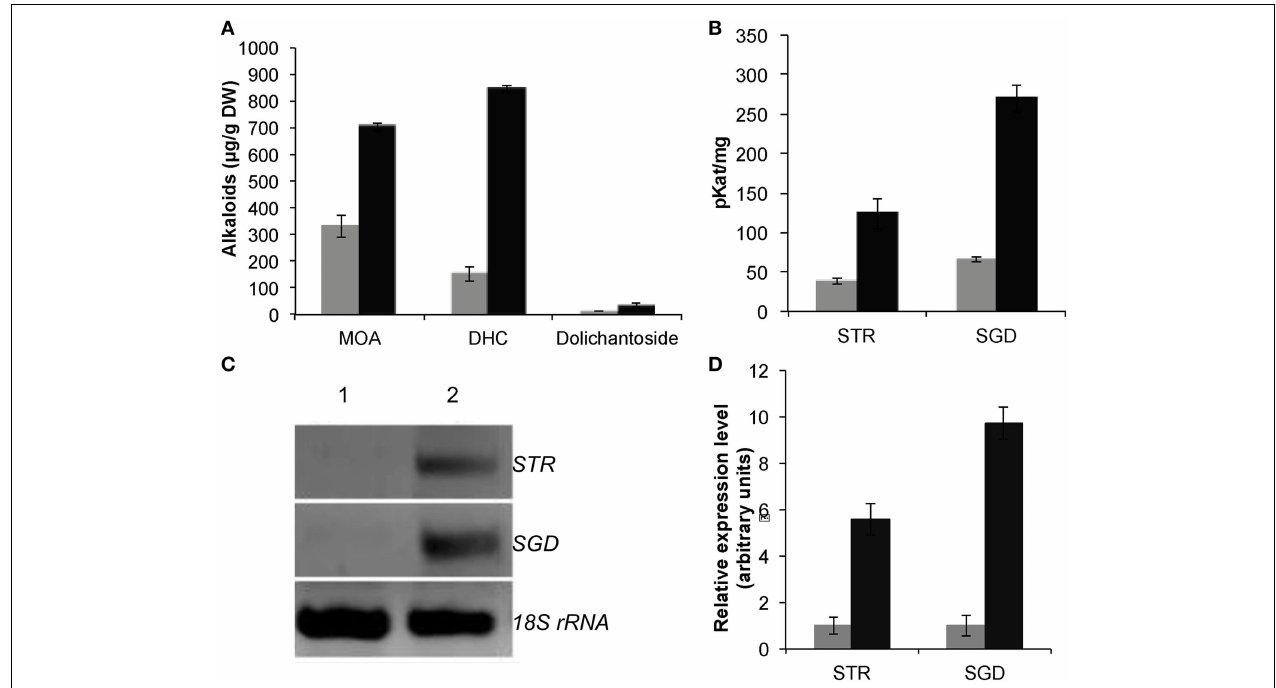
FIGURE 2 | Effect of BSO-JA elicitation on U. tomentosa root cultures growing in Erlenmeyer flasks after elicitor addition (black bars). (A) Production of MOA, DHC, and dolichantoside. (B) Specific activities of strictosidine synthase (STR) and strictosidine β -glucosidase (SGD). Error bars indicate standard deviation from the mean ( n = 3 ). Semiquantitative RT-PCR analysis of the elicitor effects in the STR and SGD mRNA transcript levels (C) Representative expression profile (The